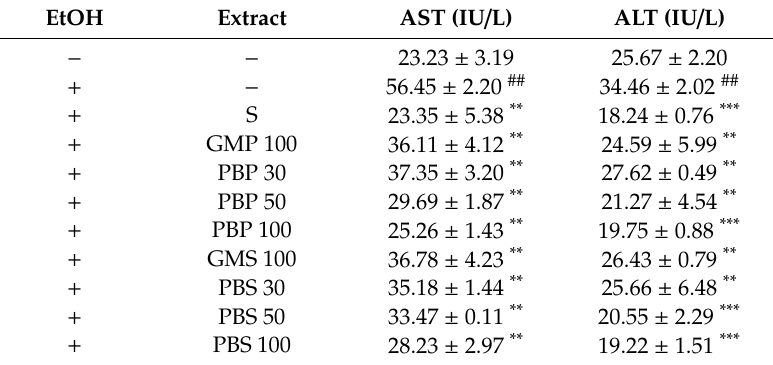
Table 2. Hepatoprotective potential of paste and sauce made from PBL koji. The AST levels in media were measured after 300 mM EtOH treatment on HepG2 cells pretreated with 95% EtOH extract of each paste and sauce. The ALT levels in media were measured after 300 mM EtOH treatment on HepG2 cells pretreated with 95% EtOH extract of each paste and sauce. EtOH Extract AST (IU / L) ALT (IU / L) − − 23.23 ± 3.19 25.67 ± 2.20 + − 56.45 ± 2.20 ## 34.46 ± 2.02 ## + S 23.35 ± 5.38 ** 18.24 ± 0.76 *** + GMP 100 36.11 ± 4.12 ** 24.59 ± 5.99 ** + PBP 30 37.35 ± 3.20 ** 27.62 ± 0.49 ** + PBP 50 29.69 ± 1.87 ** PBP 100 25.26 ± 1.43 ** 19.75 ± 0.88 *** + GMS 100 36.78 ± 4.23 ** 26.43 ± 0.79 ** + PBS 30 35.18 ± 1.44 ** 25.66 ± 6.48 ** + PBS 50 33.47 ± 0.11 ** 20.55 ± 2.29 *** + PBS 100 28.23 ± 2.97 ** 19.22 ± 1.51